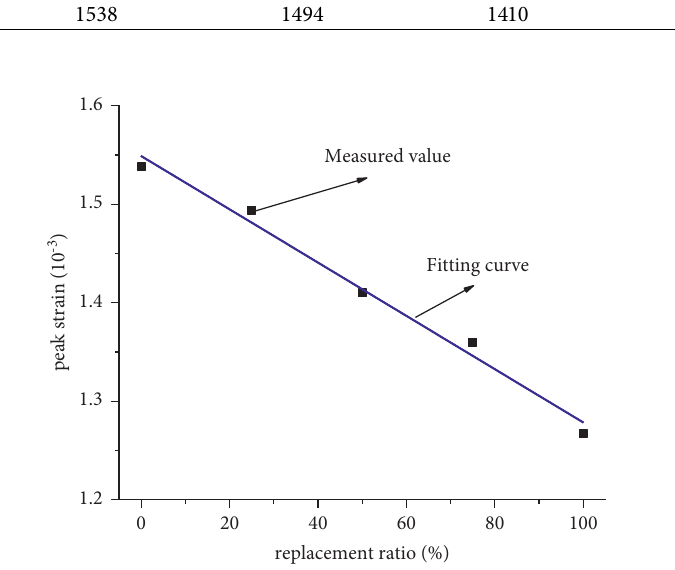
Figure 8: Different replacement ratios of peak strain fitting curves.